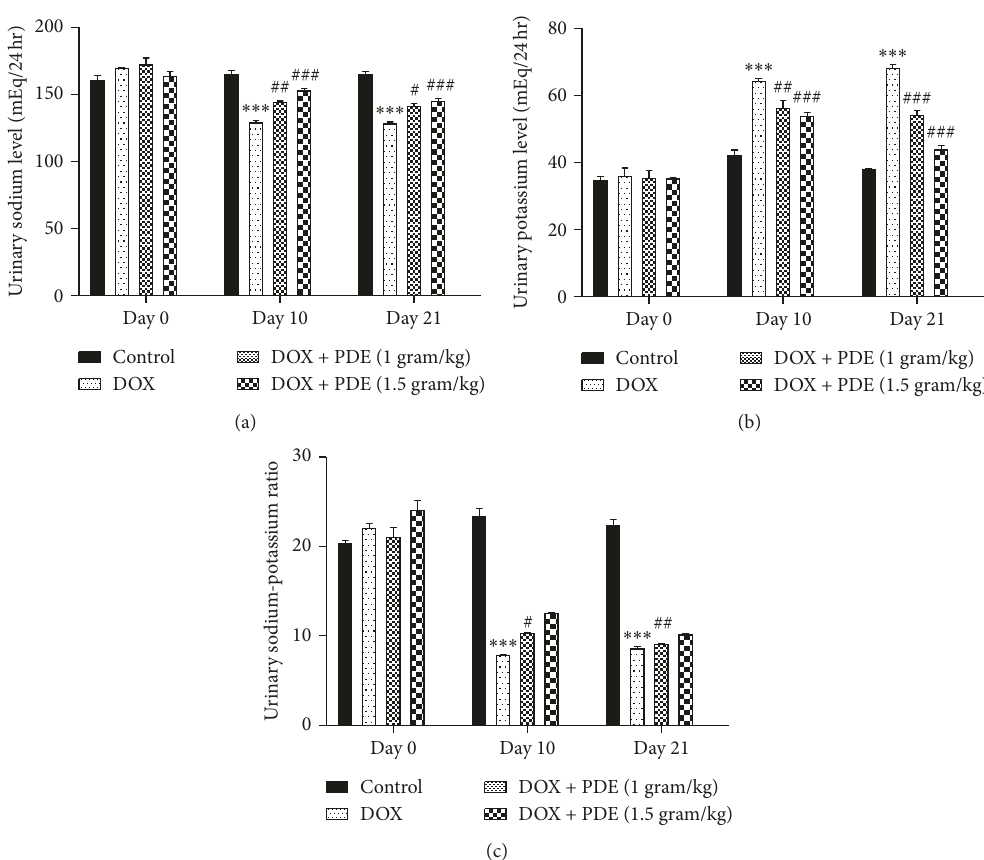
Figure 4: Effects of PDE on urinary (a) sodium, (b) potassium, and (c) sodium-potassium ratio levels in DOX-induced changes in rats. The values are mean ± SEM ( n � 6). Statistical analysis was done through two-way analysis of variance (ANOVA) followed by Bonferroni post hoc test. For determination of p values, DOX is compared with the control group, and treatment groups were compared with the DOX group. The results are considered significant if p < 0 . 05. ∗∗∗ p < 0 . 001 vs. control; # p < 0 . 05; ## p < 0 . 01 and ### p < 0 . 001 vs.